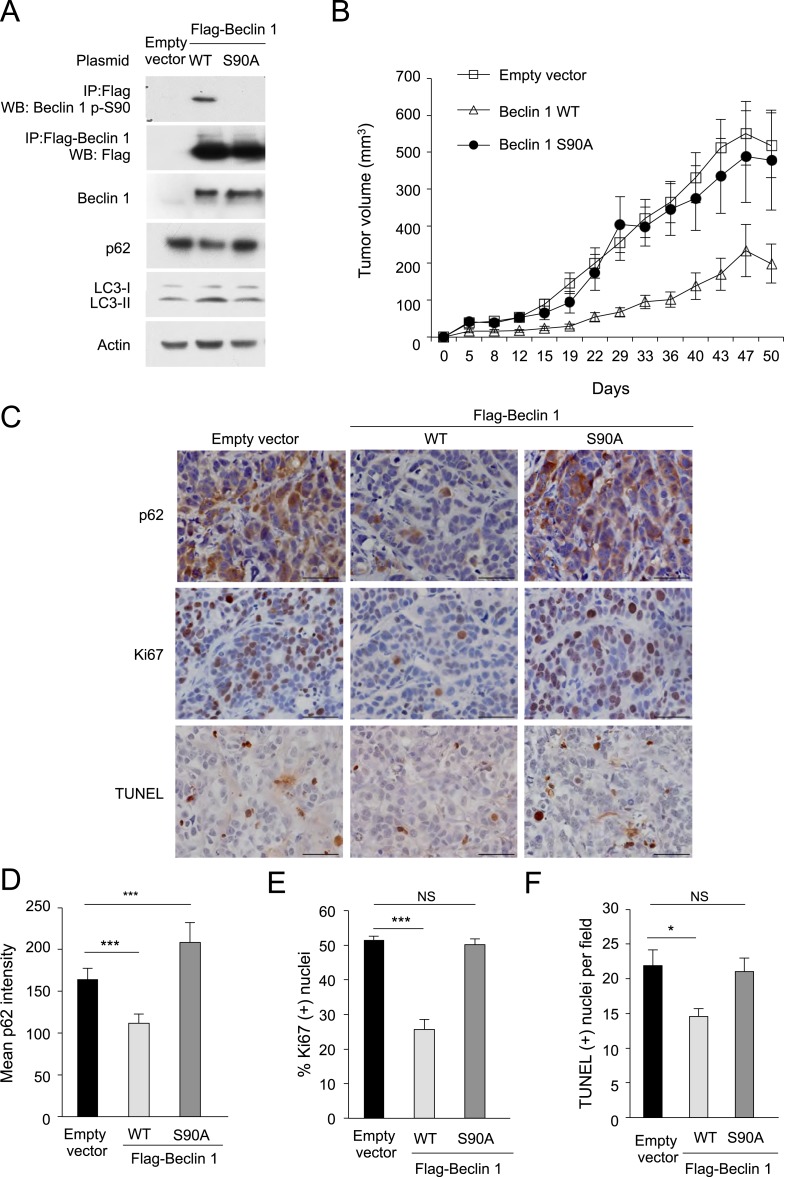
The Beclin 1 S90 phosphorylation site is required for tumor suppression function in MCF7 cells.(A) Western blot detection of Beclin 1 p-S90, Flag-Beclin 1, p62, and LC3 in MCF7 cells stably transduced with retroviruses expressing indicated Beclin 1 construct. (B) Xenograft growth of cells in (A) in nu/nu mice. Tumor volumes shown represent mean + SEM for at least 11 mice per group. Differences in tumor growth among the different groups were analyzed using a linear mixed effect model; P = NS for Beclin 1 S90A vs empty vector; p < 0.001 for Beclin 1 WT vs empty vector. (C) Representative images of p62 staining, Ki67 staining, and TUNEL-labeling of indicated MCF7 xenograft tumor genotype. (D–F) Quantification of relative reciprocal p62 intensity per high-power field (D), percentage of Ki67-positive nuclei per high-power field (E) and number of TUNEL-positive nuclei per high power field (F). At least 10 randomly selected fields per xenograft section were analyzed by an observer blinded to genotype. Bars are mean + SEM for 5–8 xenografts per MCF7 xenograft tumor genotype. ***p < 0.001, **p < 0.01, *p < 0.05, NS, not significant; one-way ANOVA with Dunnett's test.